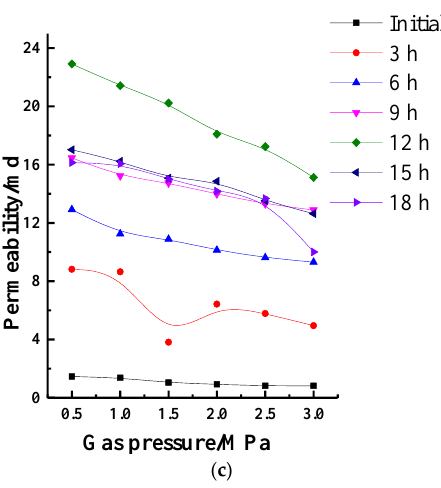
Figure 11. Permeability change trend when acid mass fraction is ( a ) 9%, ( b ) 12%, ( c ) 15%.